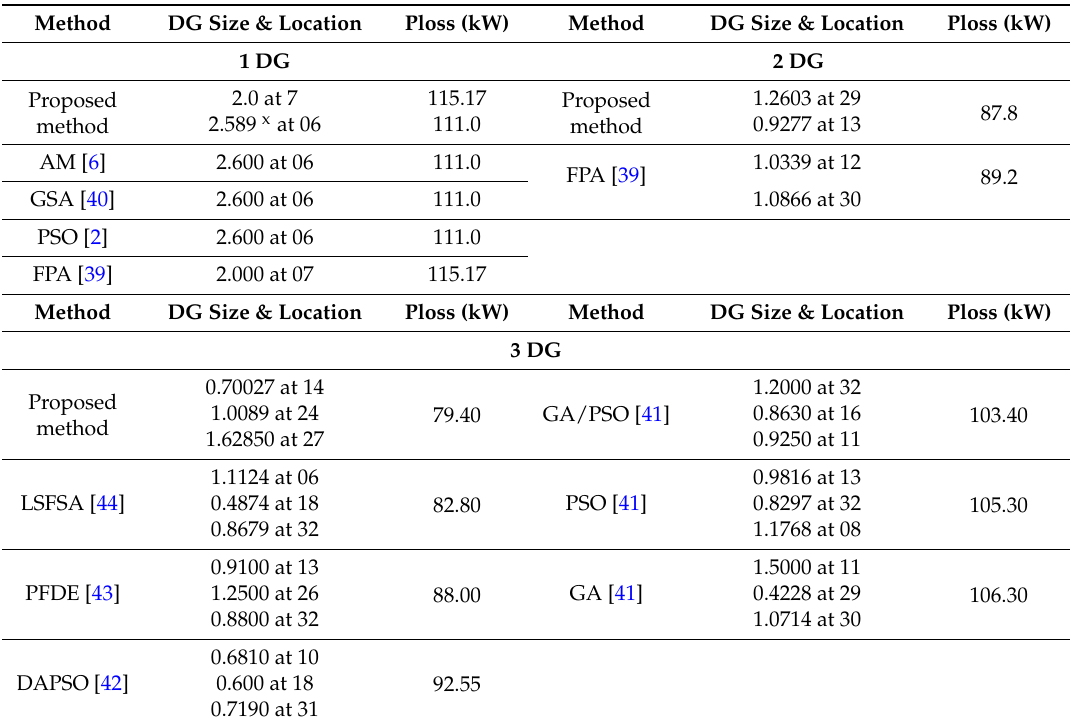
Table 2. Comparison of the proposed method with other algorithms for Type-1 DG (1st objective function).